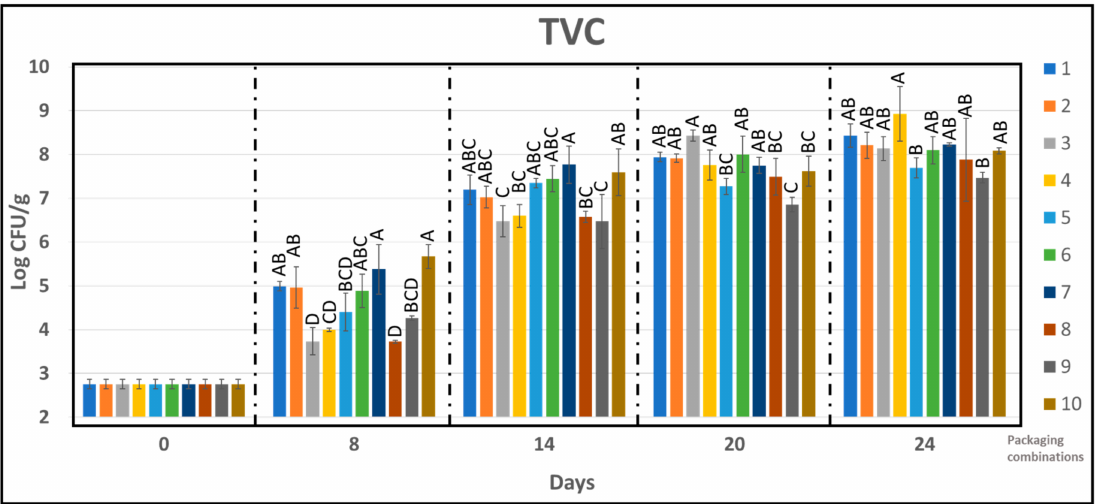
Figure 4. The effect of packaging combinations on the total viable counts (log cfu/g) in chicken samples during storage time of 24 days. One-way analysis of variance Tukey comparison is performed separately at sampling point 8, 14, 20, and 24. Tukey group is represented by upper case letters, samples which do not share the same letter are significantly